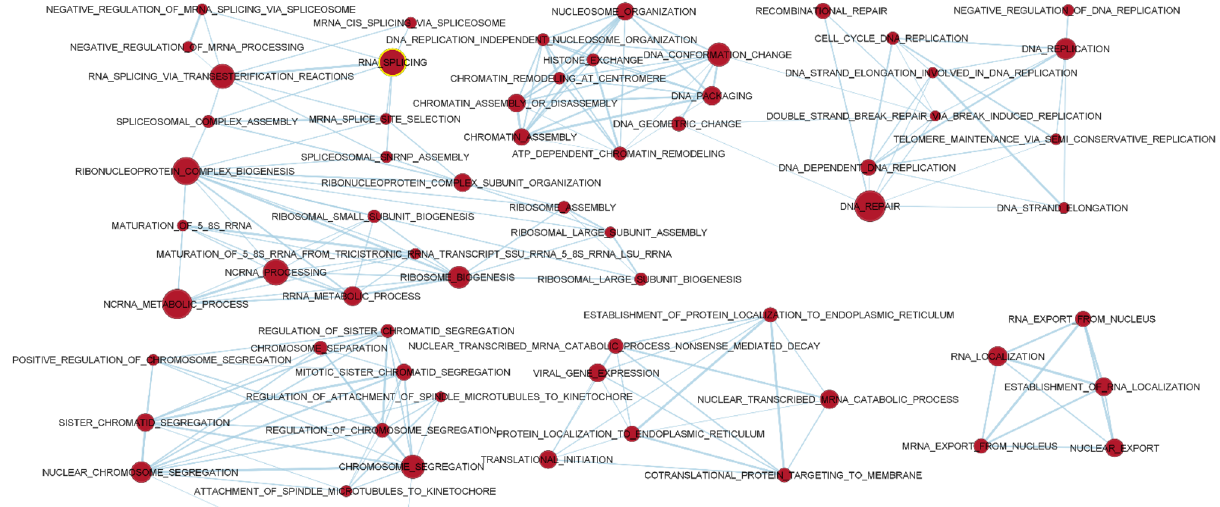
Figure 2. Gene sets upregulated in jejunal Peyer’s patches of pigs on the day of weaning as compared to those sampled in pigs at 12 days post-weaning. The sets are enriched with FDR < 0.01. The edges represent the link of two or more gene sets sharing the same core group of genes, explaining the enrichment of each of the gene sets. Node colour intensity conveys enrichment significance (P-value) while their dimension increases with the number of their genes.